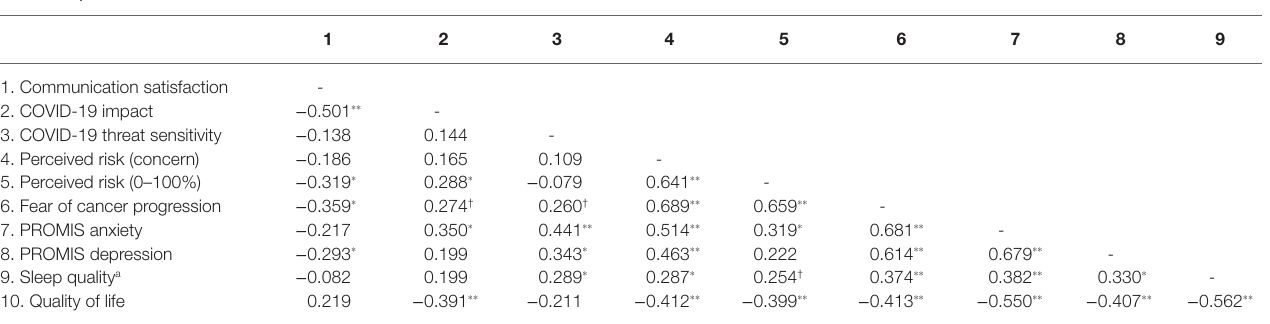
TABLE 3 | Bivariate correlations.